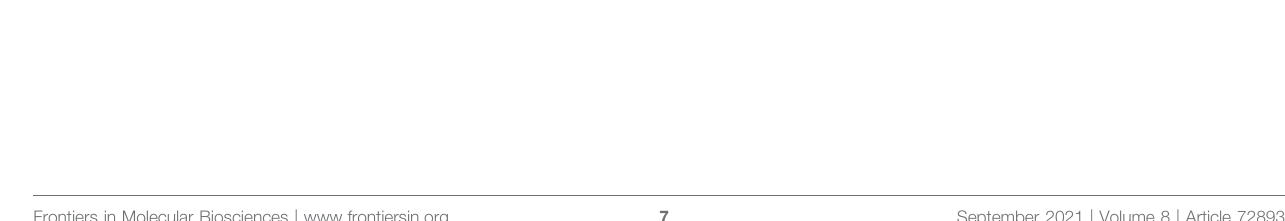
Frontiers in Molecular Biosciences |